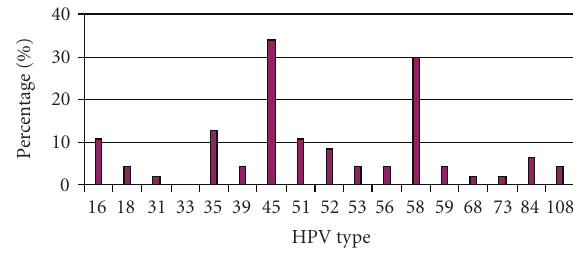
Figure 2: High risk HPV type